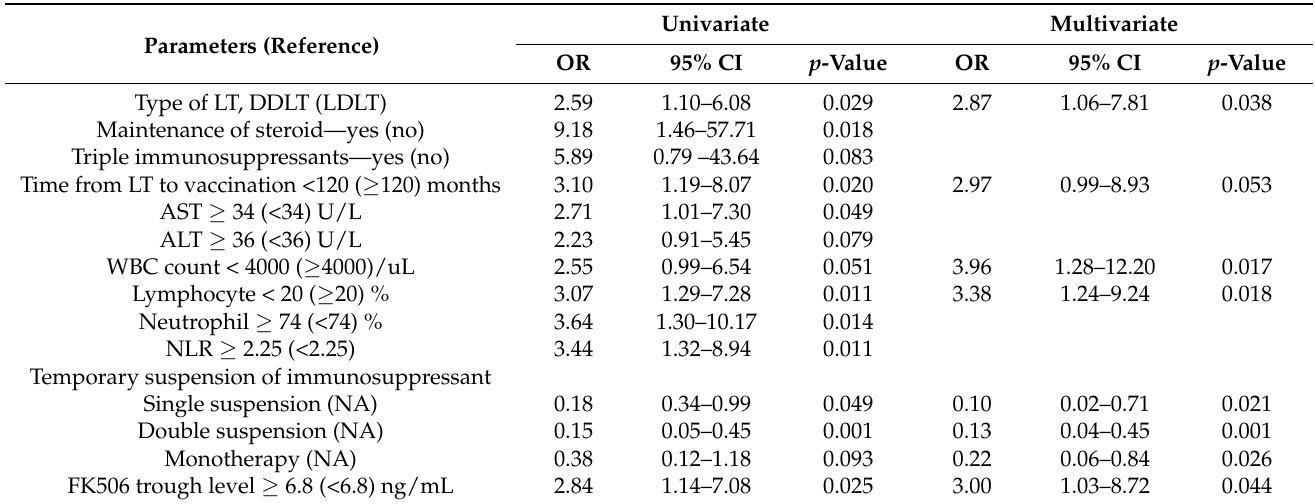
Table 2. Uni-/multivariate analyses in predicting negative humoral response after two-dose Moderna mRNA-1273 vaccines in liver transplant recipients.